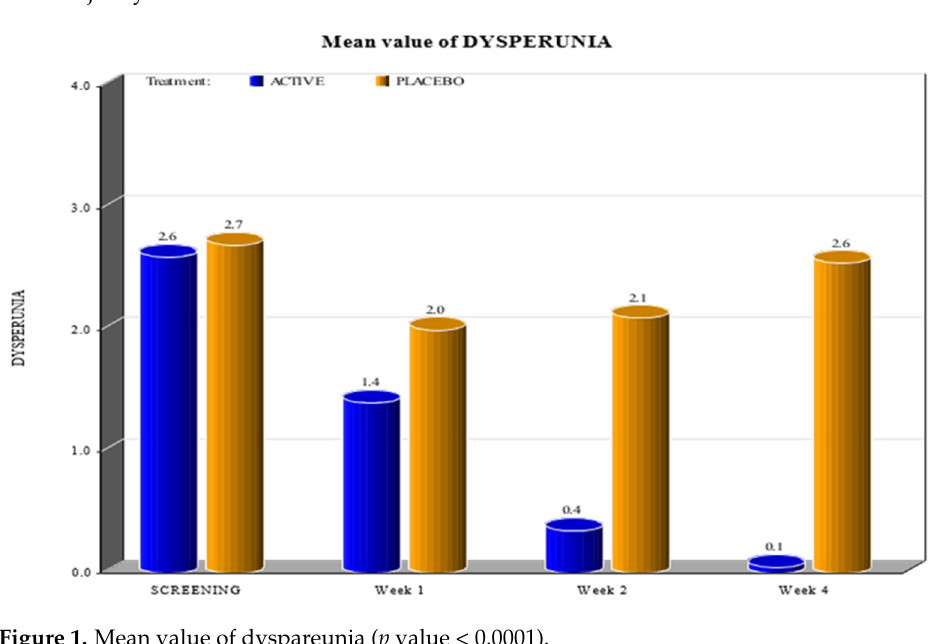
Figure 1. Mean value of dyspareunia ( p value < 0.0001).